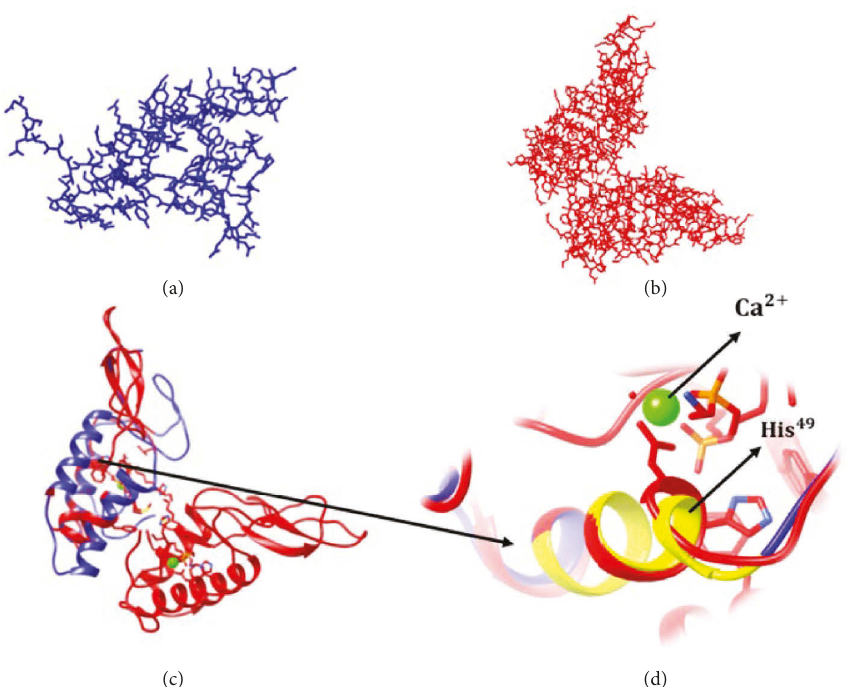
Figure 7: Superimposition of 3D structure of bee venom and Maurolipin. 3D structure of Maurolipin is similar to the chain A of bee venom . (a) and (b): the 3D structure predicted by DeepView/Swiss-PdbViewer (version 4.10) software. (c): the Superimposition predicted by PLA 2 UCSF Chimera (version 1.14) software. In both pictures, the blue color shows Maurolipin and the red color shows bee venom PLA yellow color shows Maurolipin active site. Table 2: RMSD of active site residues in an important domain in Maurolipin and bee venom PLA Amino acid